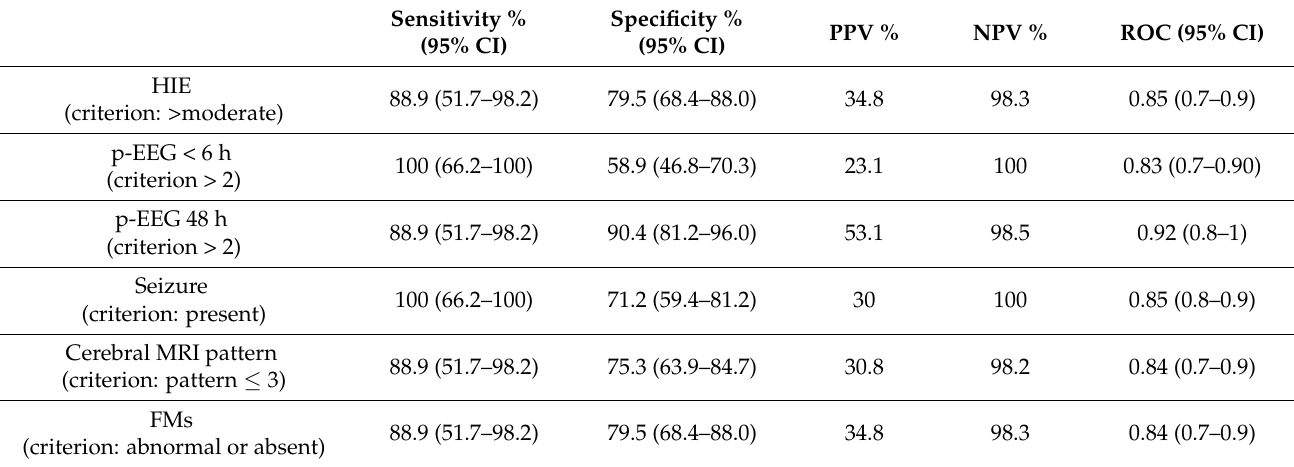
Table 5. Prognostic accuracy for severe outcome in infants undergoing